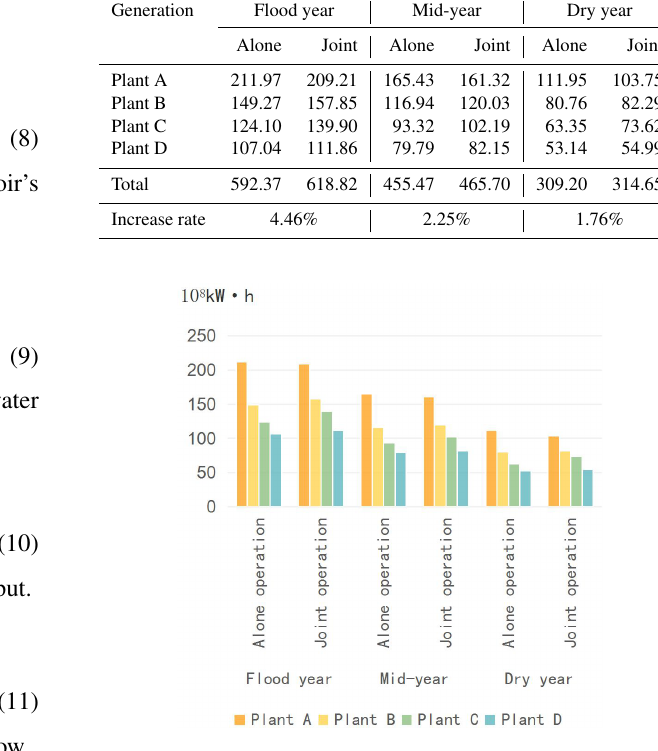
Figure 2. Cascade power